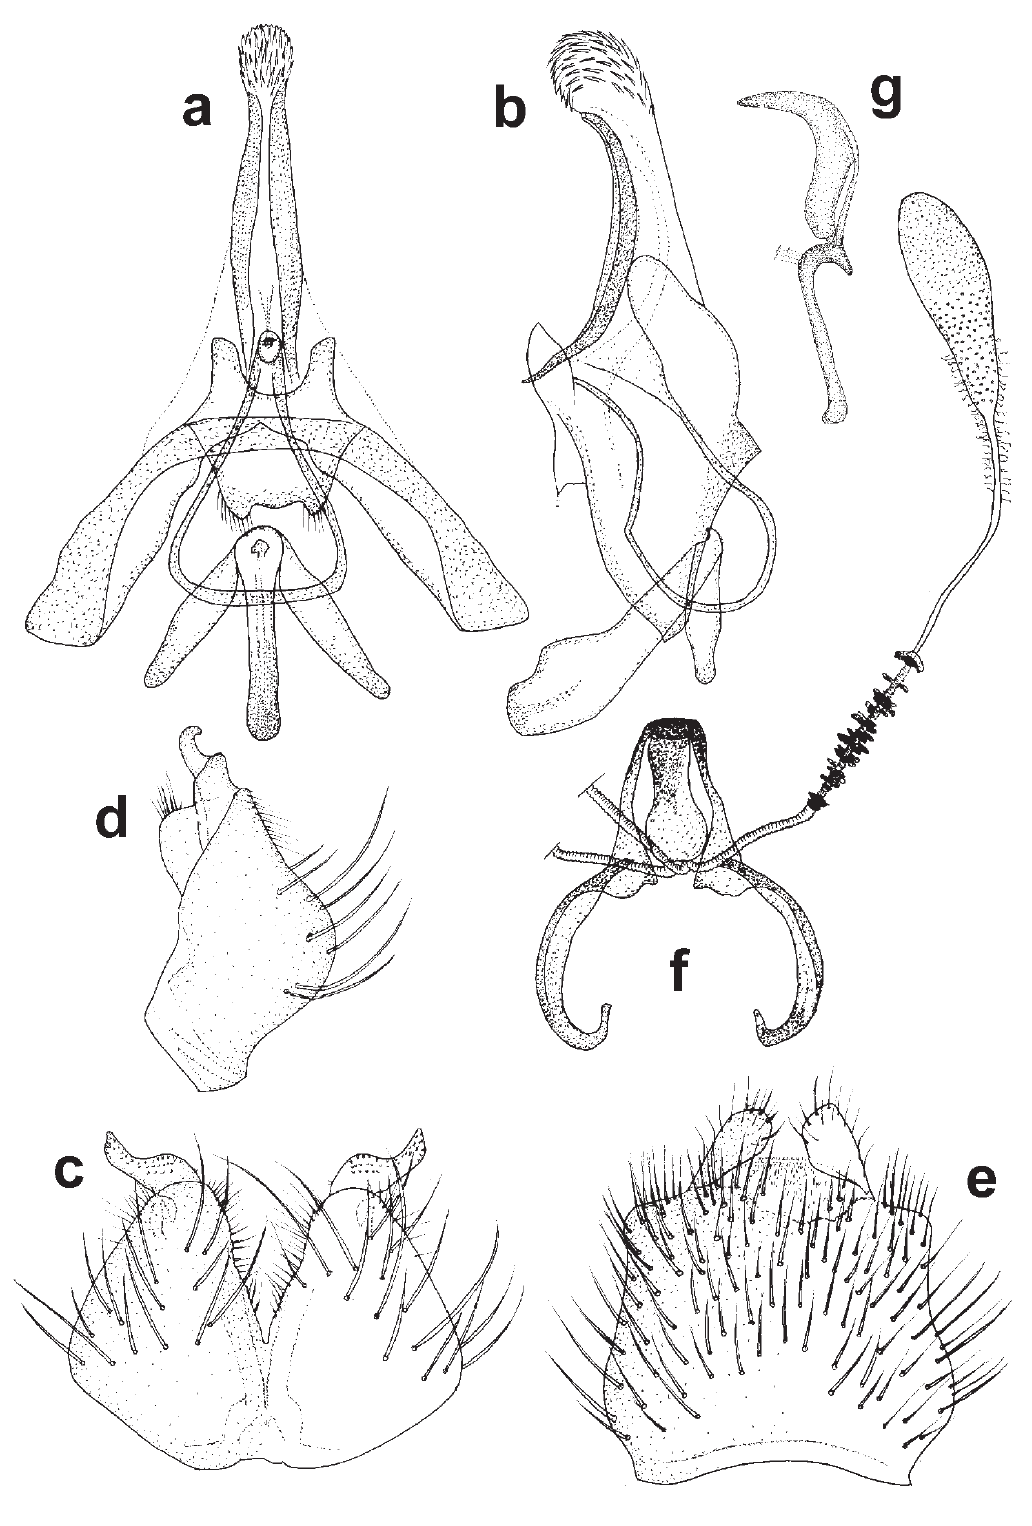
Fig. 40. Protypusia grata (Loew, 1856) comb. nov. a . Epiphallic complex ventral. b . Epiphallic complex lateral. c . Gonocoxite ventral. d . Gonocoxite lateral. e . Epandrium dorsal. f . Female genitalia ventral. g . Female genitalia